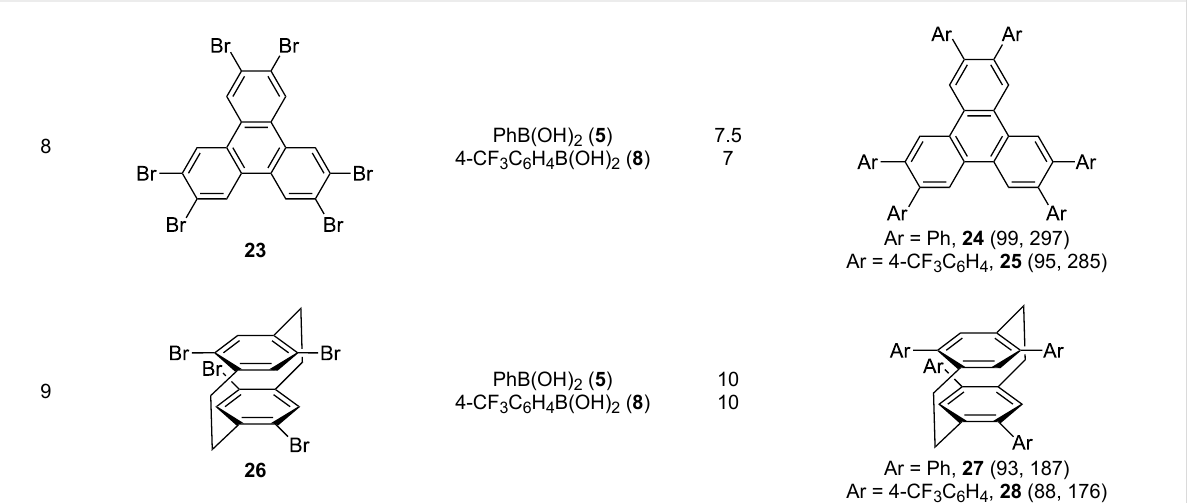
Table 1: Multiple Suzuki–Miyaura coupling of polybromoarenes with arylboronic acids by using complex 1 a .